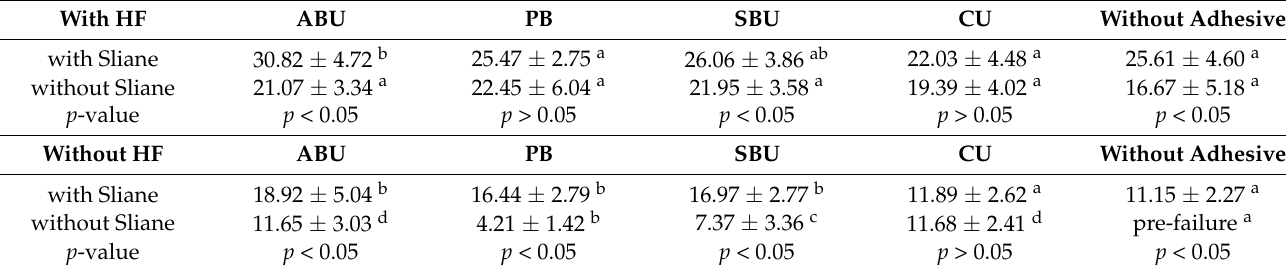
Table 2. µ TBS values (MPa) in each group ( n = 15).